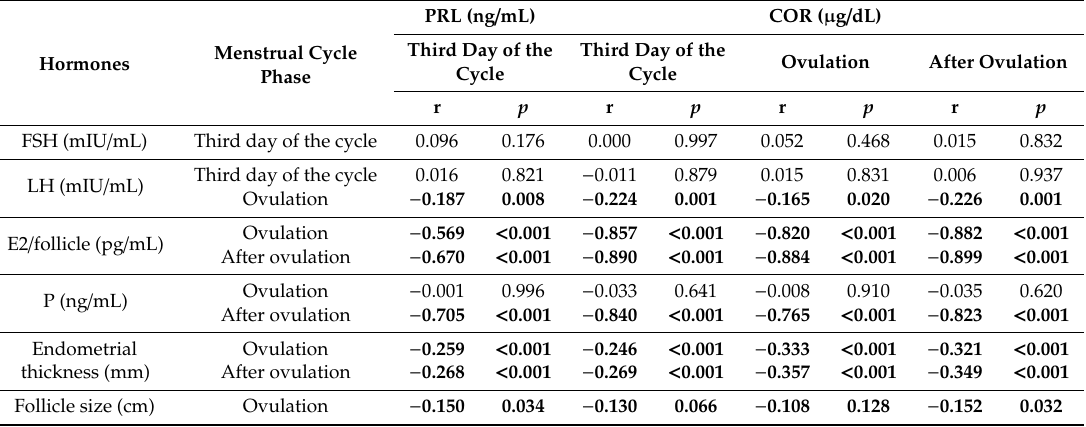
Table 2. Correlations between prolactin (PRL) and cortisol (COR) levels and the menstrual cycle course in women from the study group ( N = 205). Significant correlations are in bold. Pearson’s correlation coe ffi cient was